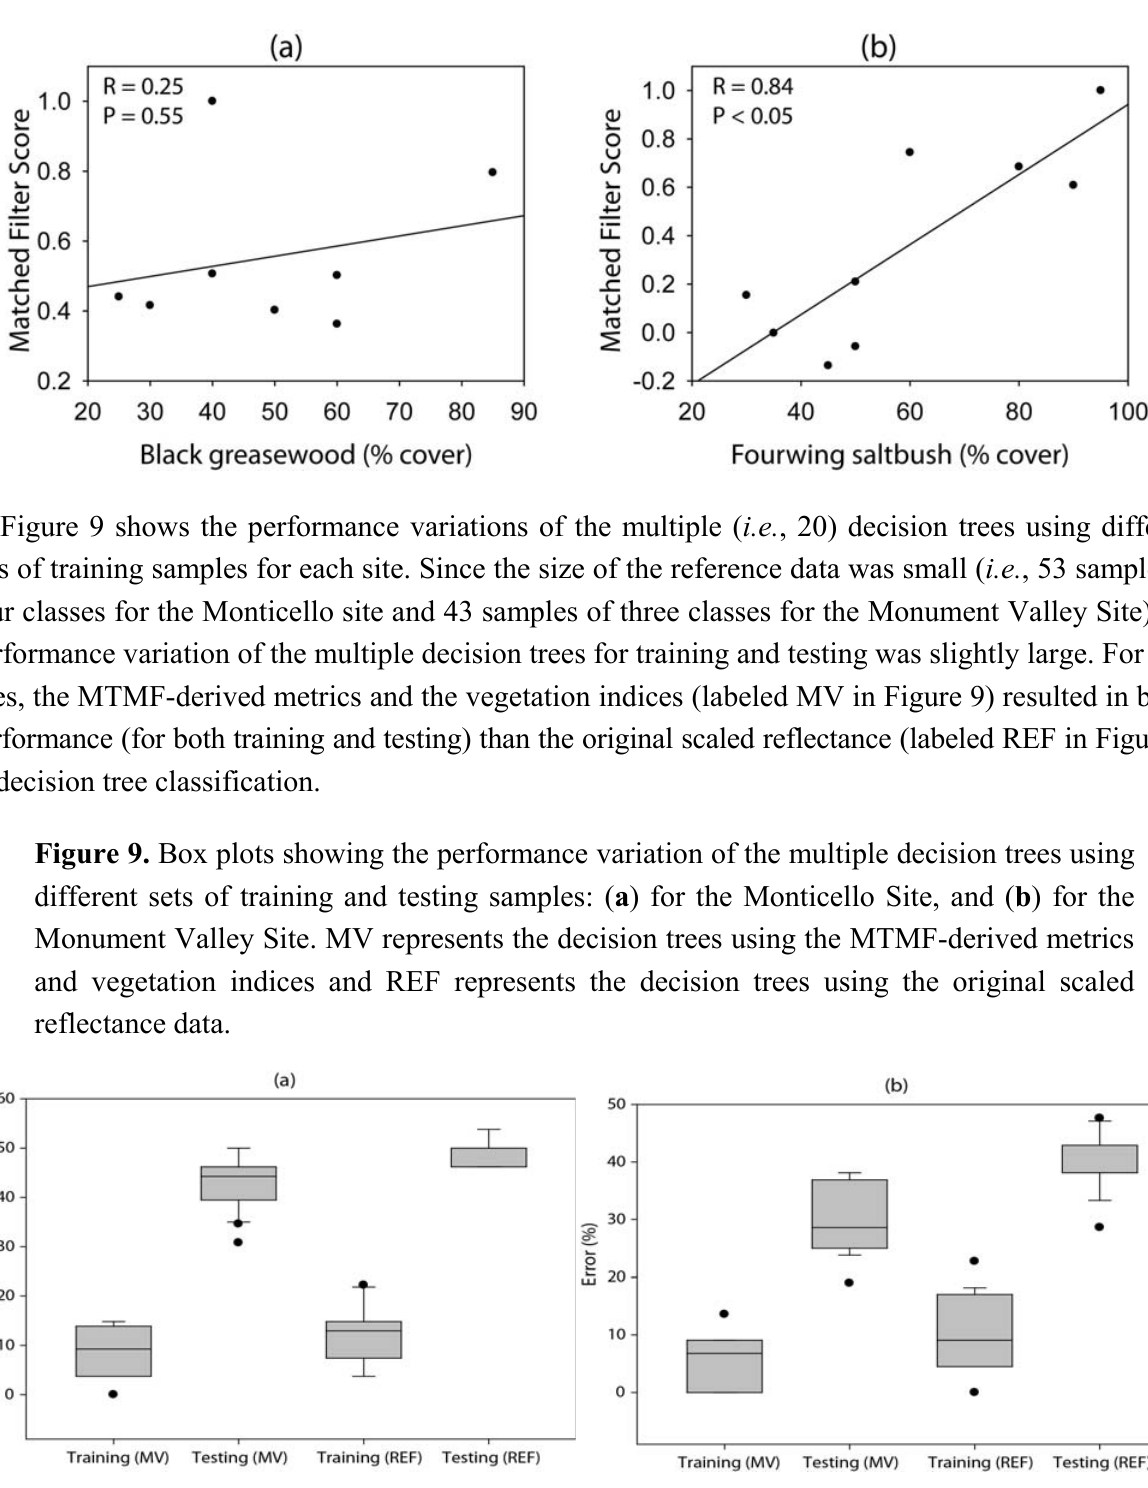
Figure 8. The relationships between the matched filter scores and the percent cover of the vegetation species for the Monument Valley site: ( a ) greasewood and ( b ) saltbush.